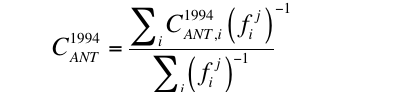
and section 28ºW plotted. B, WOA05 data grid sample ANT with θ (ºC).